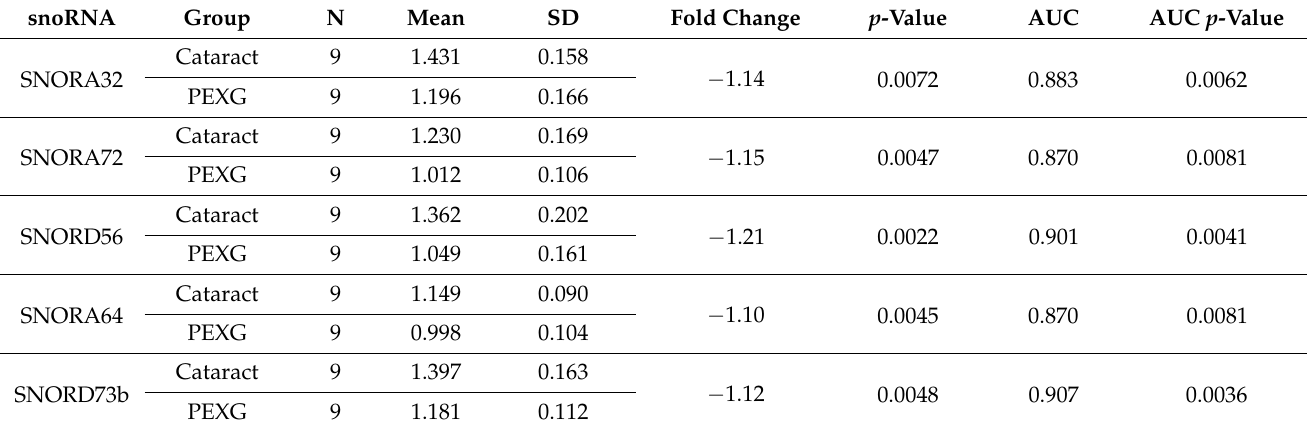
Table 4. Lower snoRNAs’ expression in the PEXG group compared to the cataract group